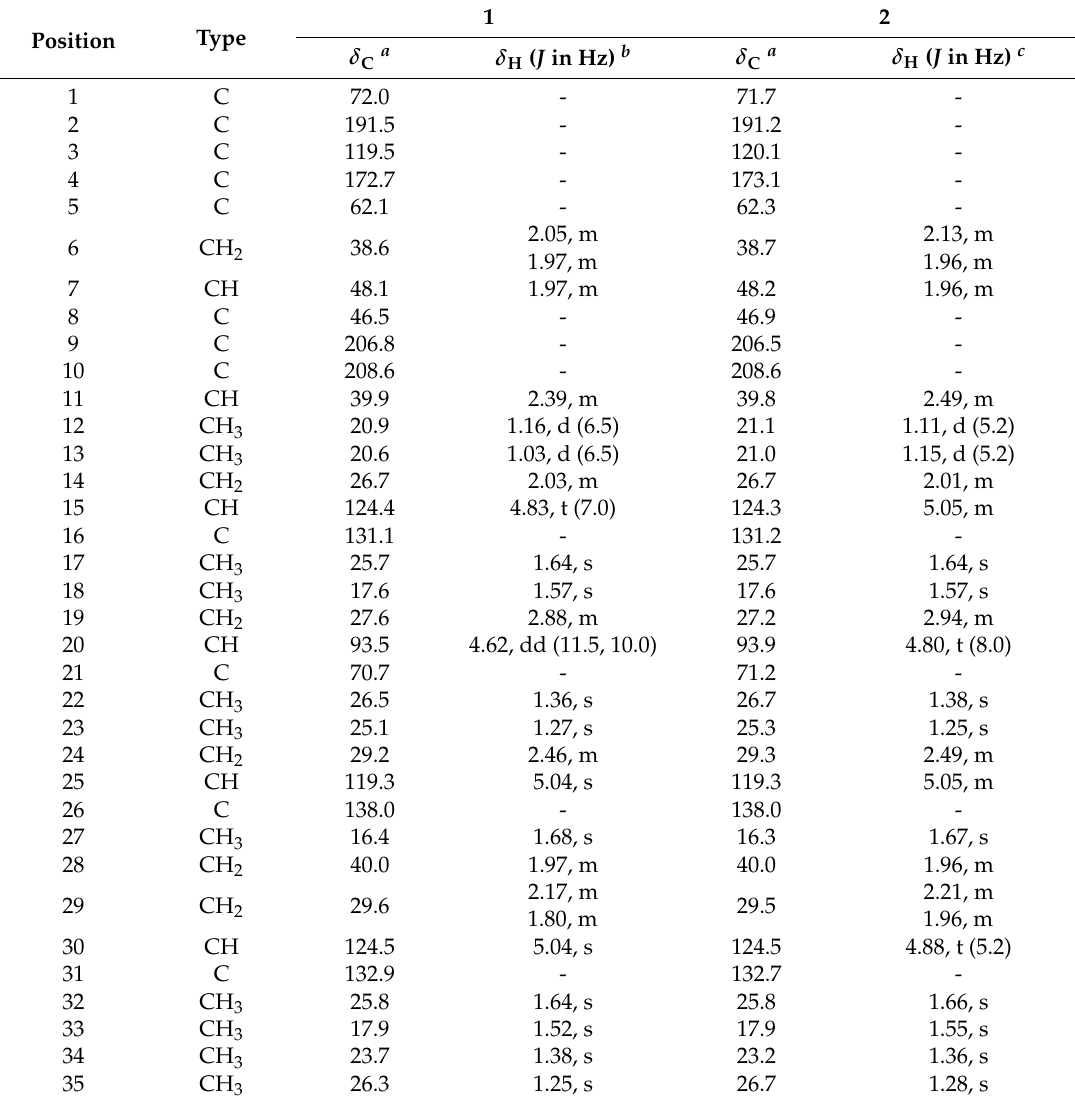
Table 1. 1 H- and 13 C-NMR data for 1 and 2 in CDCl 3